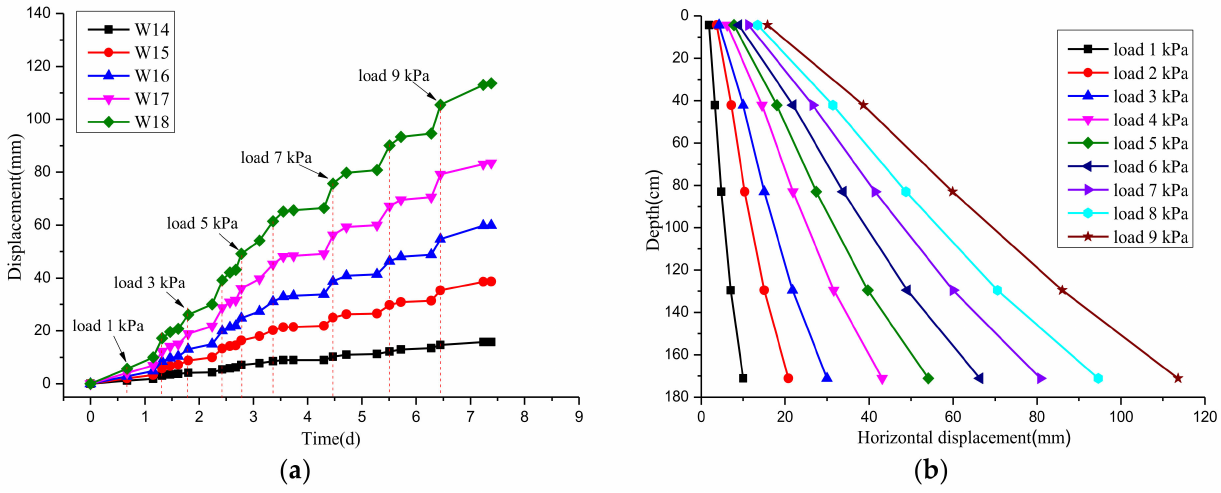
Figure 18. Horizontal displacement curves of the slope surface: ( a ) horizontal displacement variation curve of the slope surface; ( b ) horizontal displacement distribution curve of the slope